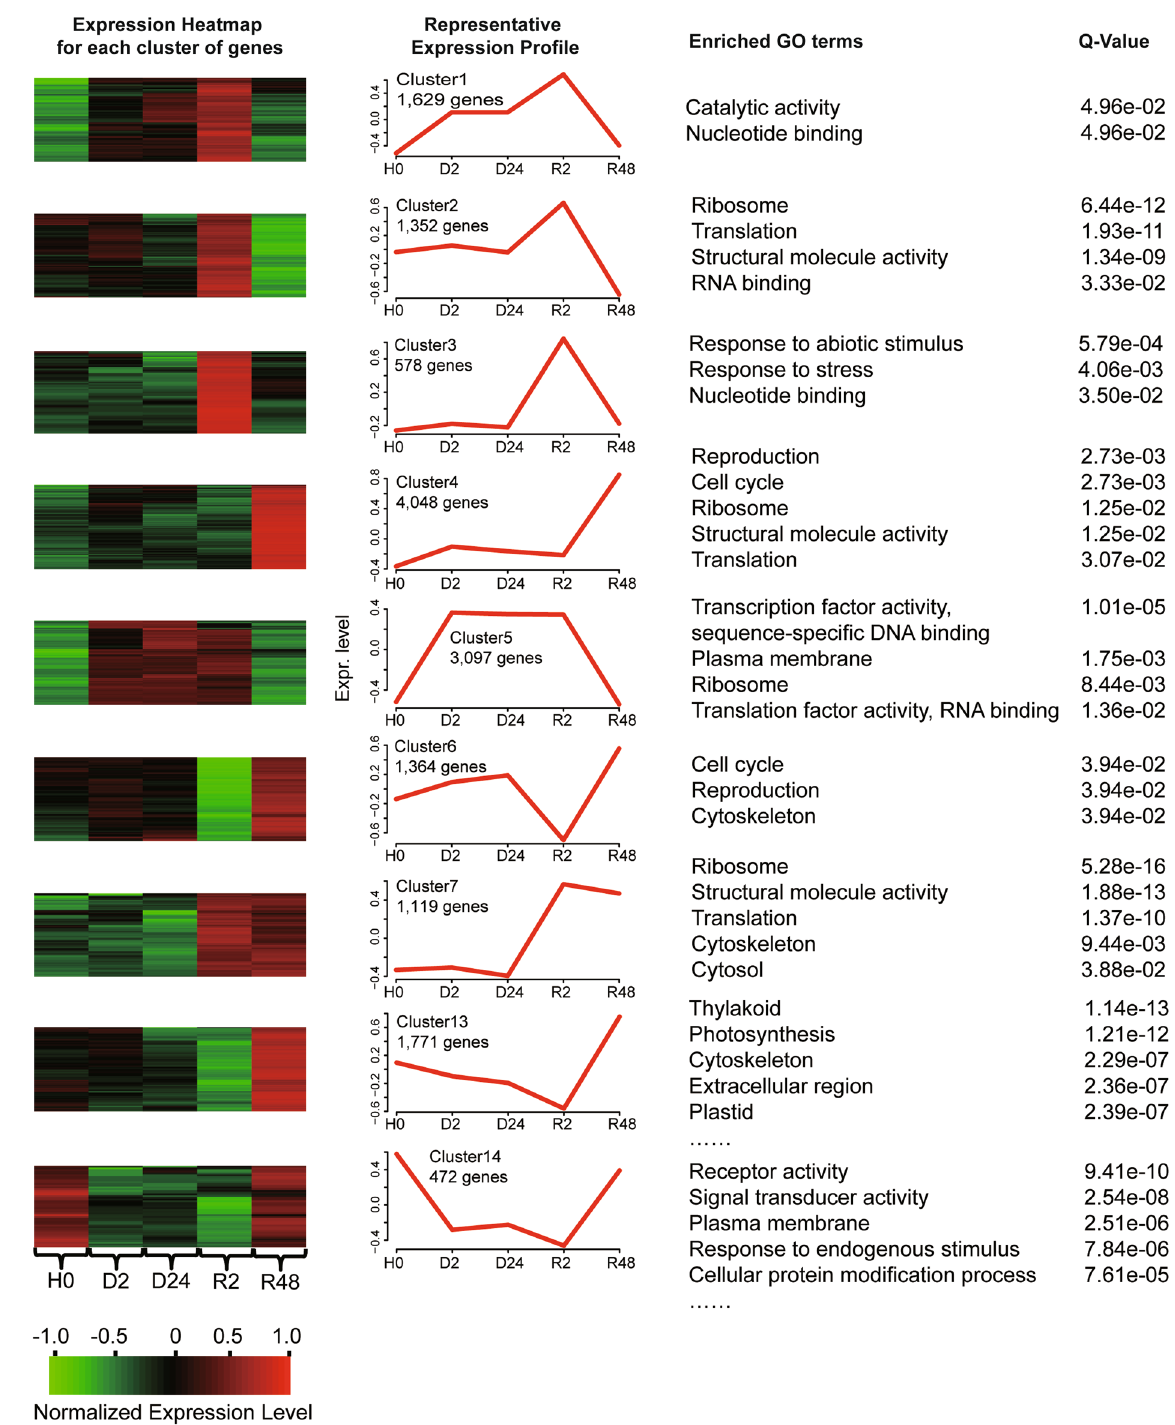
Figure 2. Clusters of genes showing representative expression patterns during dehydration and rehydration. All of the significantly differentially abundant transcripts (SDATs) were selected, then SOTA function in the clValid package was employed to classify these SDATs into 16 categories. The nine categories with significantly enriched GO terms were shown here. The top GO slim-plant terms and corresponding enrichment FDR values were shown in the right